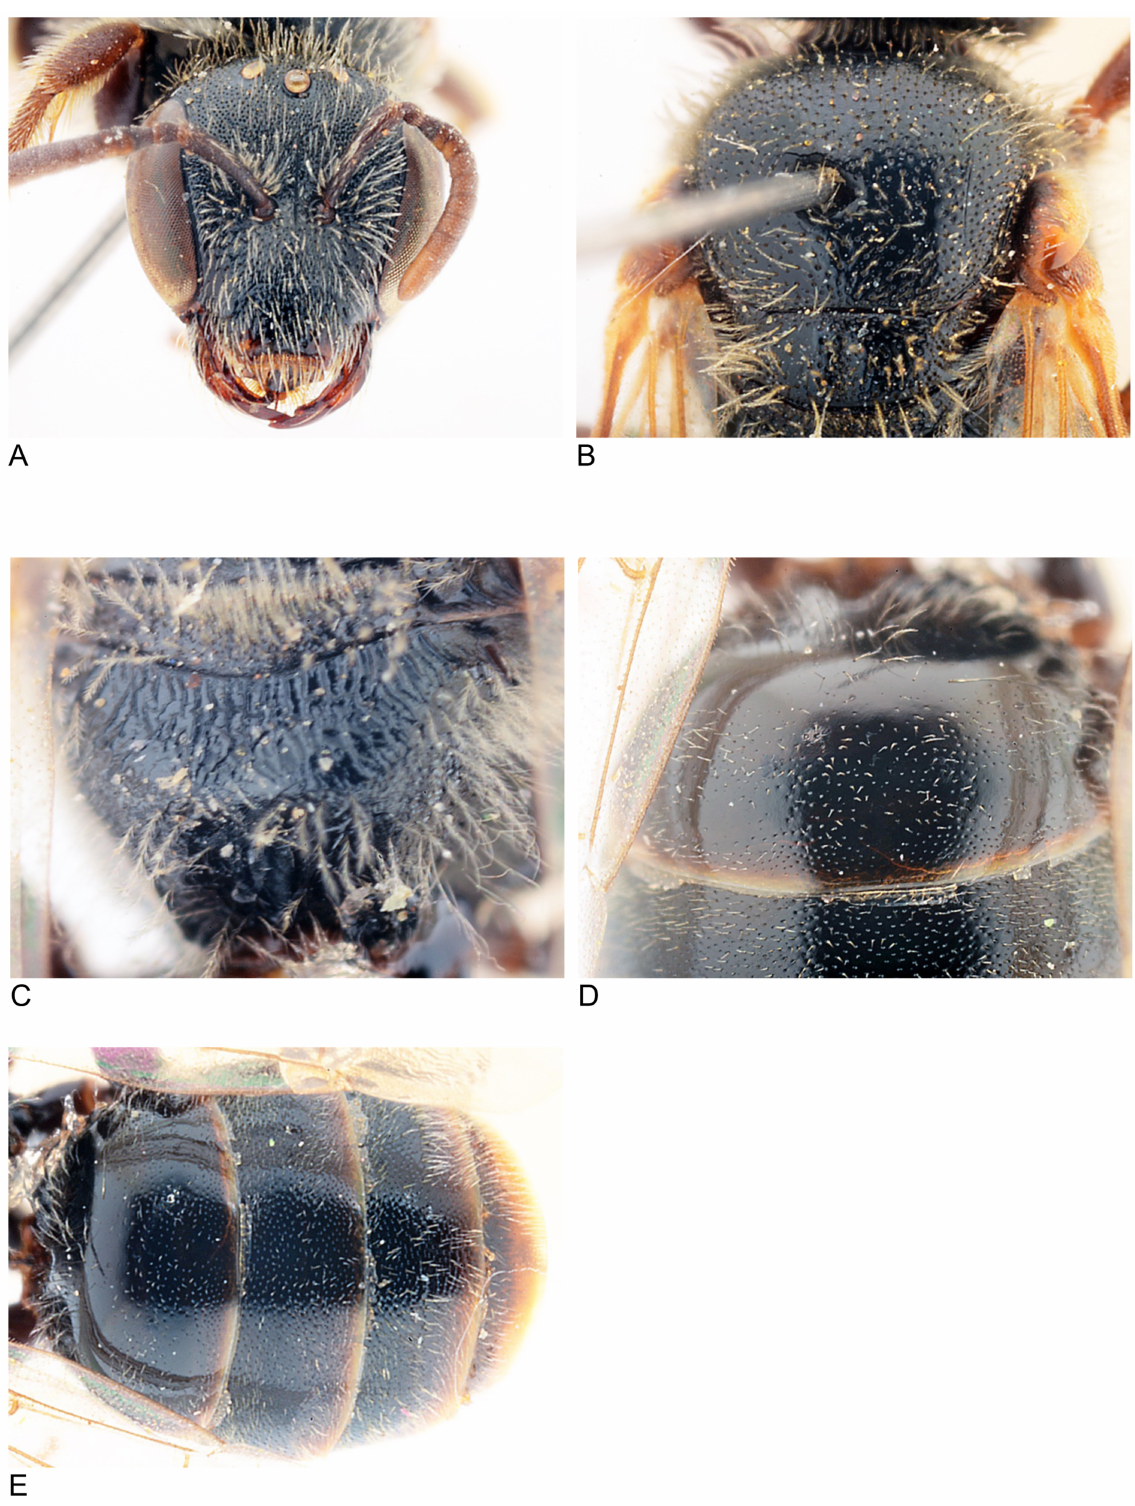
Fig. 10. Halictus villiersi Benoist, 1941, holotype, ♀. A . Head. B . Scutum. C . Propodeum. D . First tergum. E .